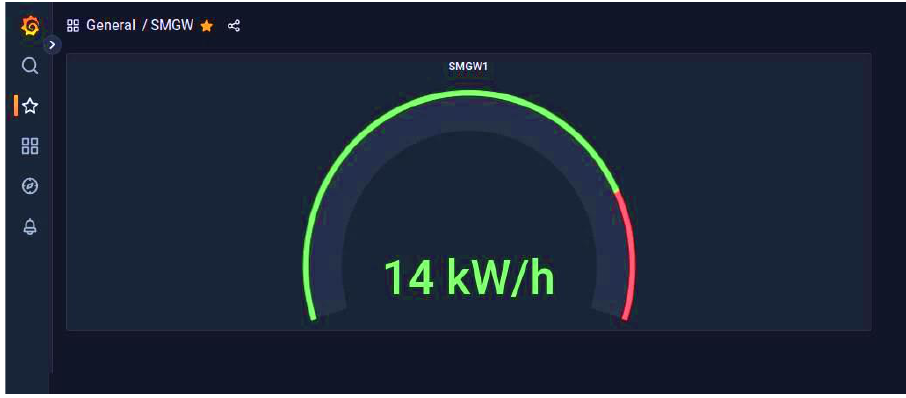
Figure 23. Received encrypted data.